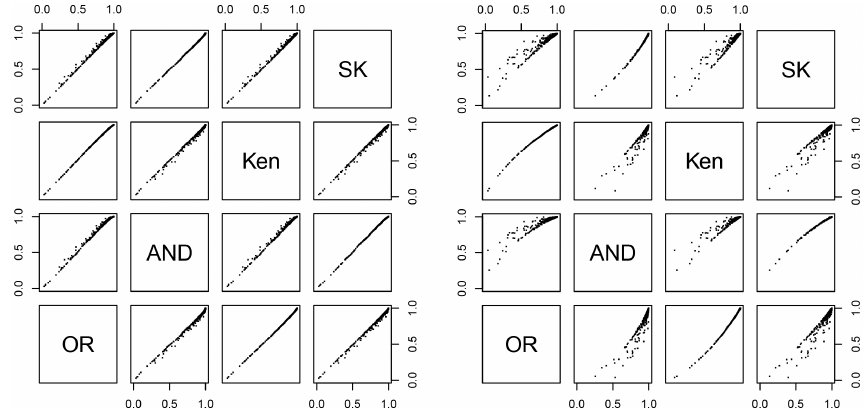
Figure 2. Comparison of the annual maximum value for the four different definitions. Left: based on 500 years of simulated rainfall data. Right: moderately correlated sample of a Gumbel